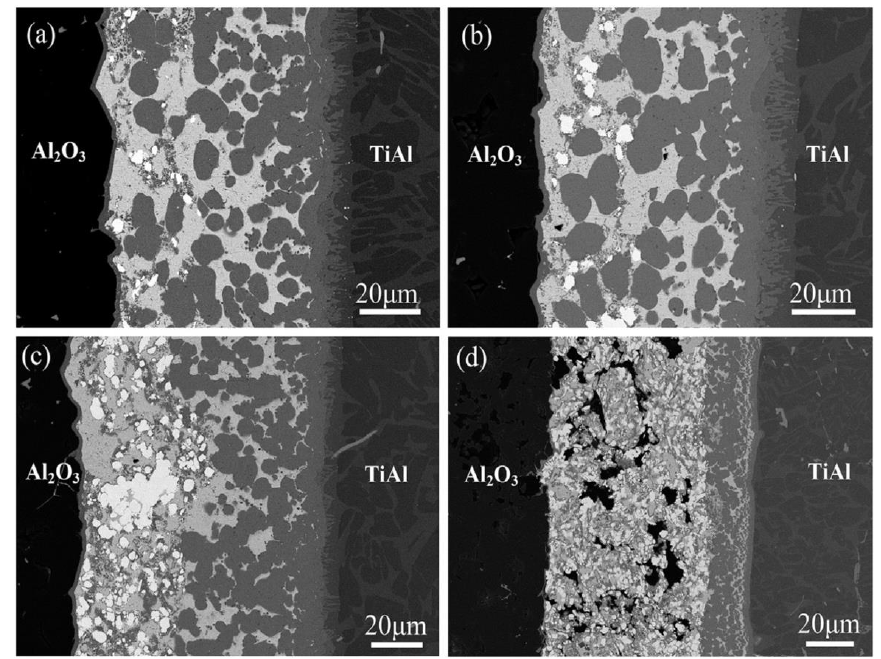
Figure 1. Effect of W content on the microstructure of Al 2 O 3 /Ag-Cu-Ti+W/TiAl joints brazed at 880 °C for 10 min: ( a ) 5; ( b ) 10; ( c ) 30 and ( d ) 40 wt% W, reproduced from Reference [22], with permission of Elsevier, 2017.